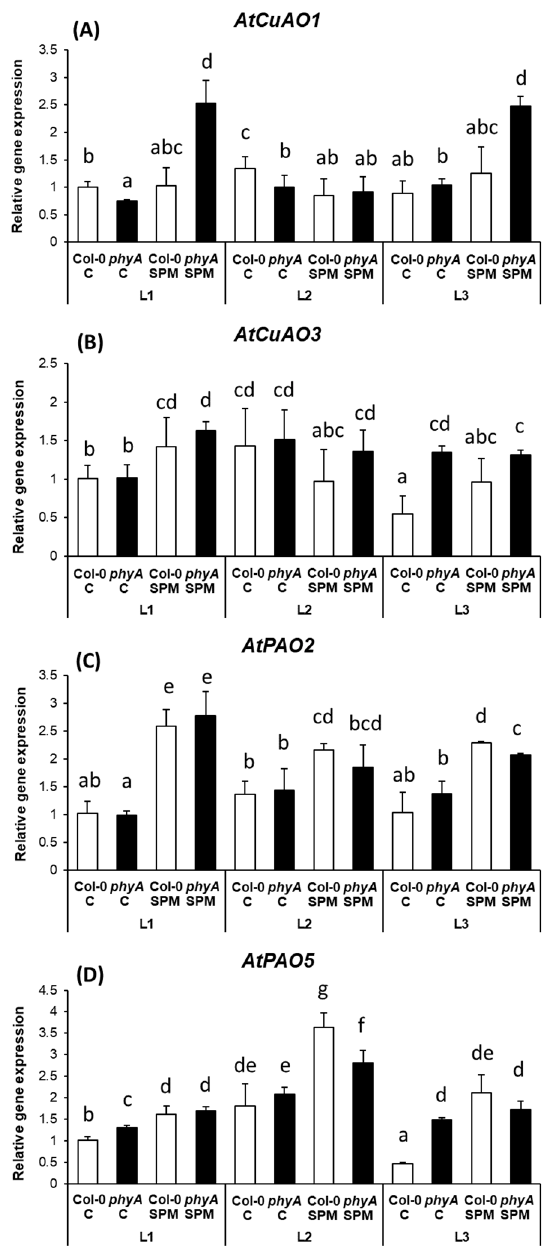
Figure 4. Changes in the expression levels of polyamine metabolism-related genes, namely copper- containing amine oxidases ( AtCuAO1 : ( A ) and AtCuAO3 : ( B )), and polyamine oxidases ( AtPAO2 : ( C ) and AtPAO5 : ( D )) in the leaves of wild type (Col-0) and mutant ( phyA ) Arabidopsis plants grown under three different light regimes (L1: blue%: 19.139, green%: 30.62, red%: 48.8 and far-red%: 1.44; L2: blue%: 19.57, green%: 29.57, red%: 40.43 and far-red%: 10.43; L3: blue%: 39.38, green%: 28.76, red%: 30.53 and far-red%: 1.33) treated with or without 0.5 mM spermine (control: C and spermine: SPM). Values are means ± SD (n = 3). Different letters indicate statistically significant differences at p < 0.05 level, using Duncan’s post hoc